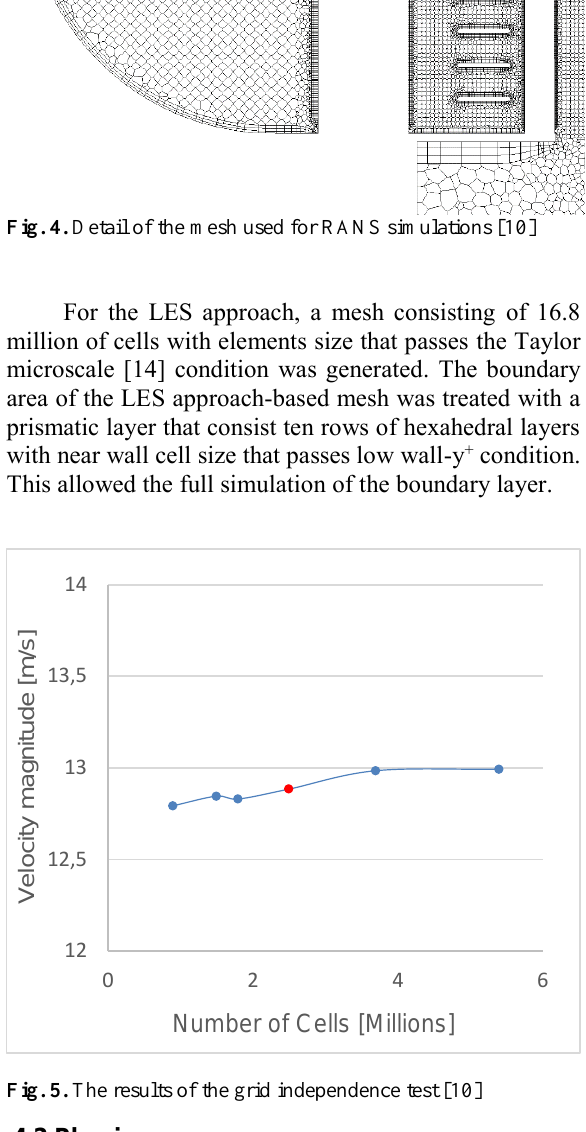
Fig. 5. The results of the grid independence test